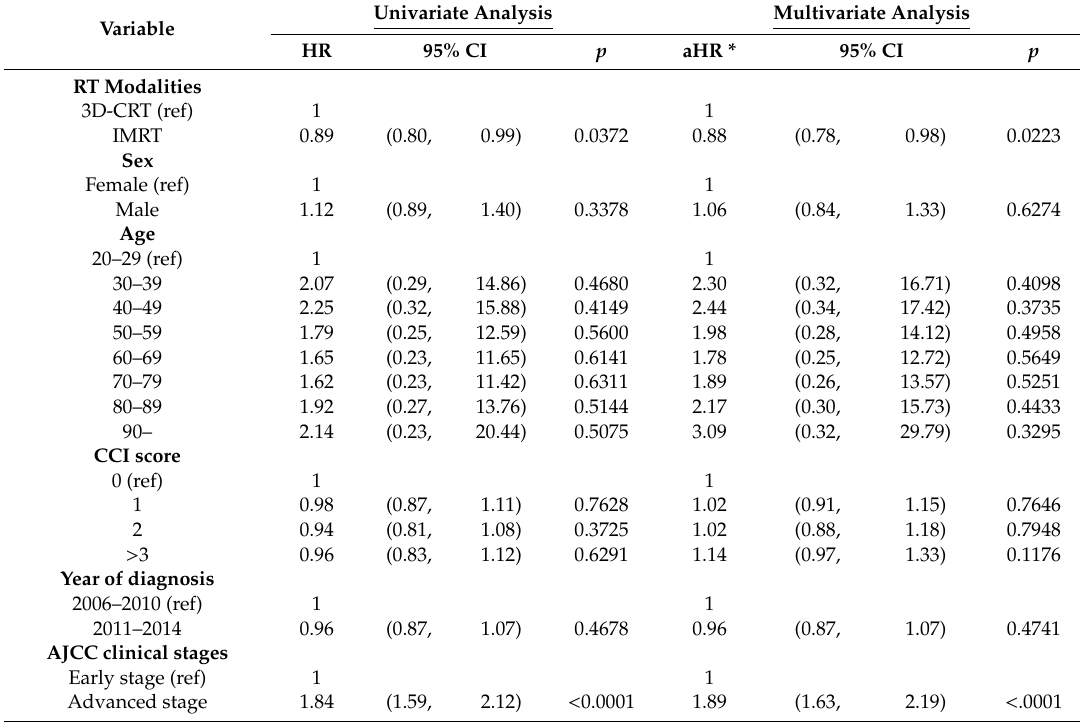
Table 2. Cox proportional hazard regression analysis of mortality risk among patients with TESCC receiving concurrent chemoradiotherapy